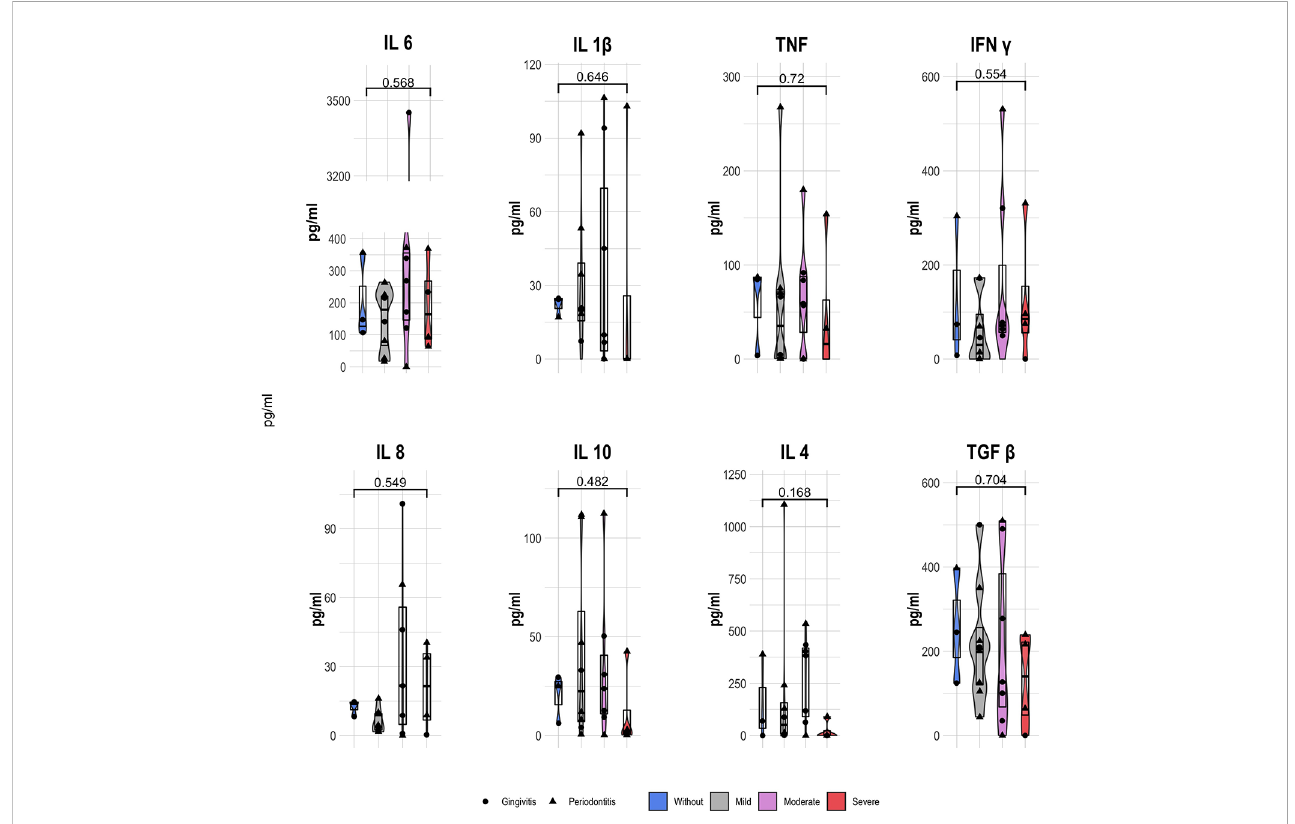
FIGURE 4 Serum cytokine concentration (pg/ml) of STEMI patients according the in fl ammation-based risk scoring system; showing the median and 25th y 75th quartile; p value, Kruskal